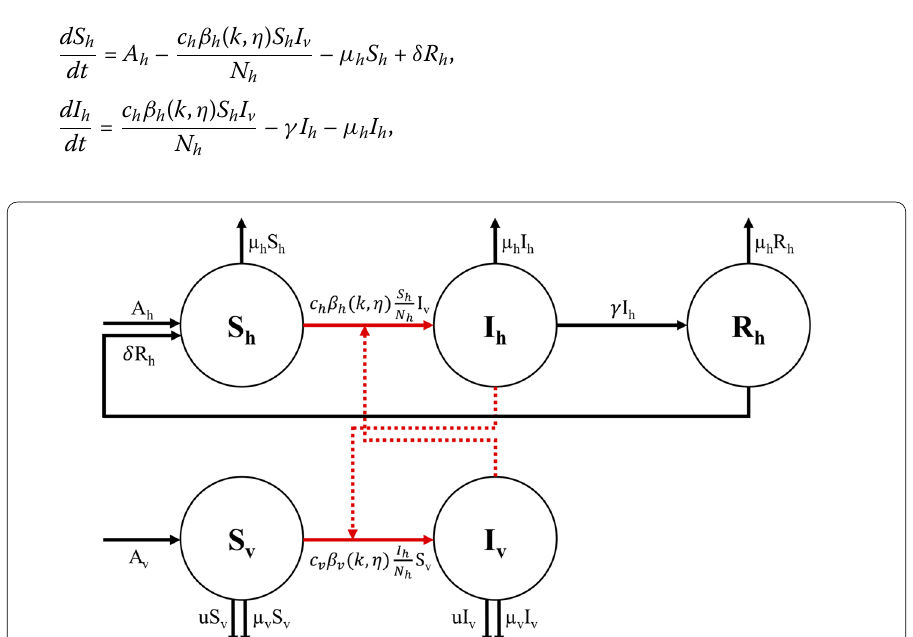
Figure 1 Transmission diagram for the SIR-SI model. The spread of malaria disease with fumigation and bed nets as a means of intervention. The red arrows indicate the infection process, whereas black arrows indicate the transition